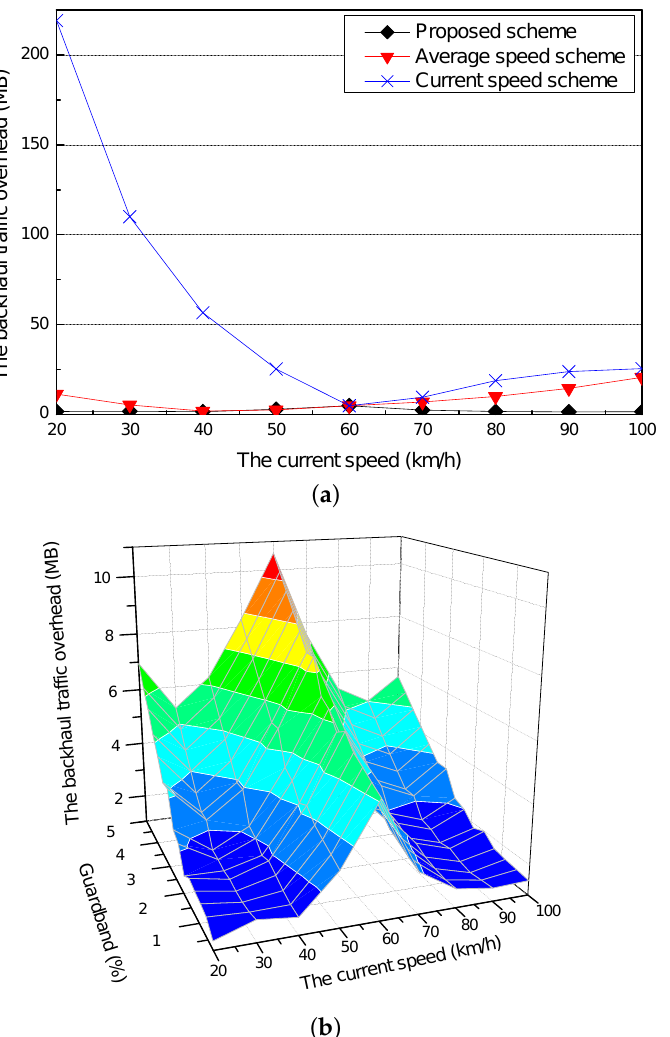
Figure 8. Simulation results for the different current speeds: ( a ) the backhaul traffic overhead and ( b ) the backhaul traffic overhead for different